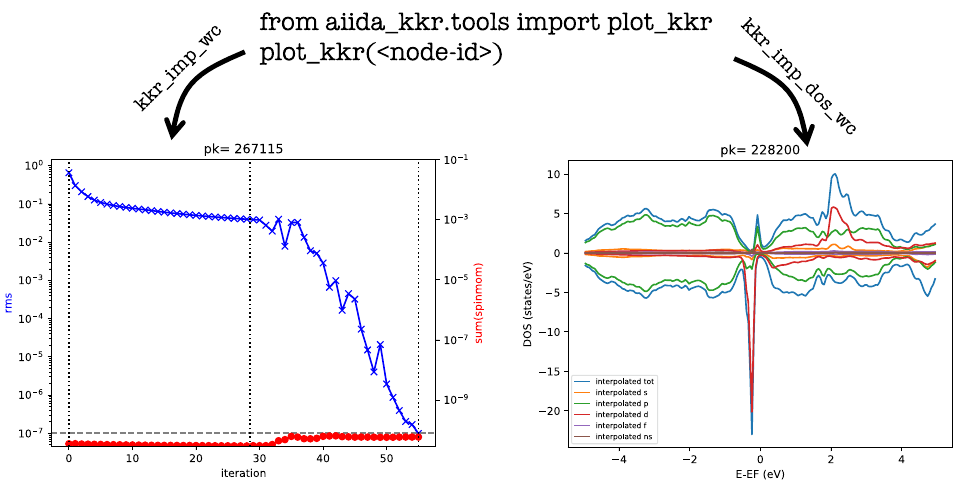
Fig. 2 The plot_kkr tool of AiiDA-KKR. Illustration of typical plots generated with the plot_kkr tool of AiiDA-KKR (left: convergence behavior of a kkr_imp_wc work fl ow, right: DOS output of a kkr_imp_dos_wc work fl ow).